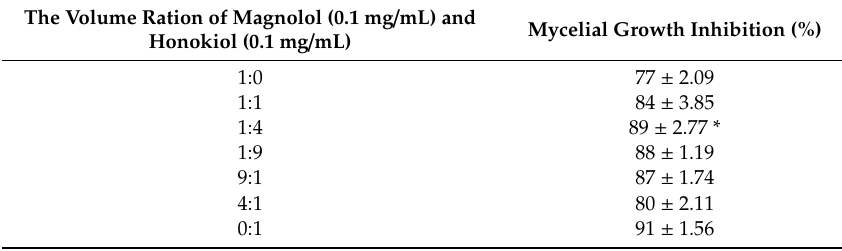
Table 2. The synergistic e ff ect of magnolol and honokiol on A. alternata . The Volume Ration of Magnolol (0.1 mg / mL) and Mycelial Growth Inhibition Honokiol (0.1 mg / mL)